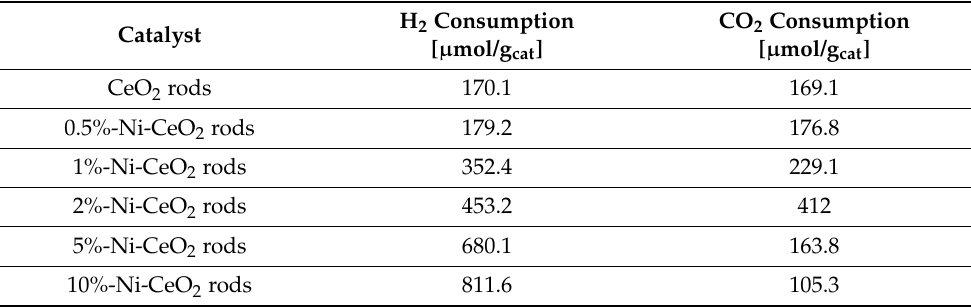
Table 5. The overall amount of hydrogen consumed in H 2 -TPR and oxygen consumed in CO 2 pulse chemisorption.